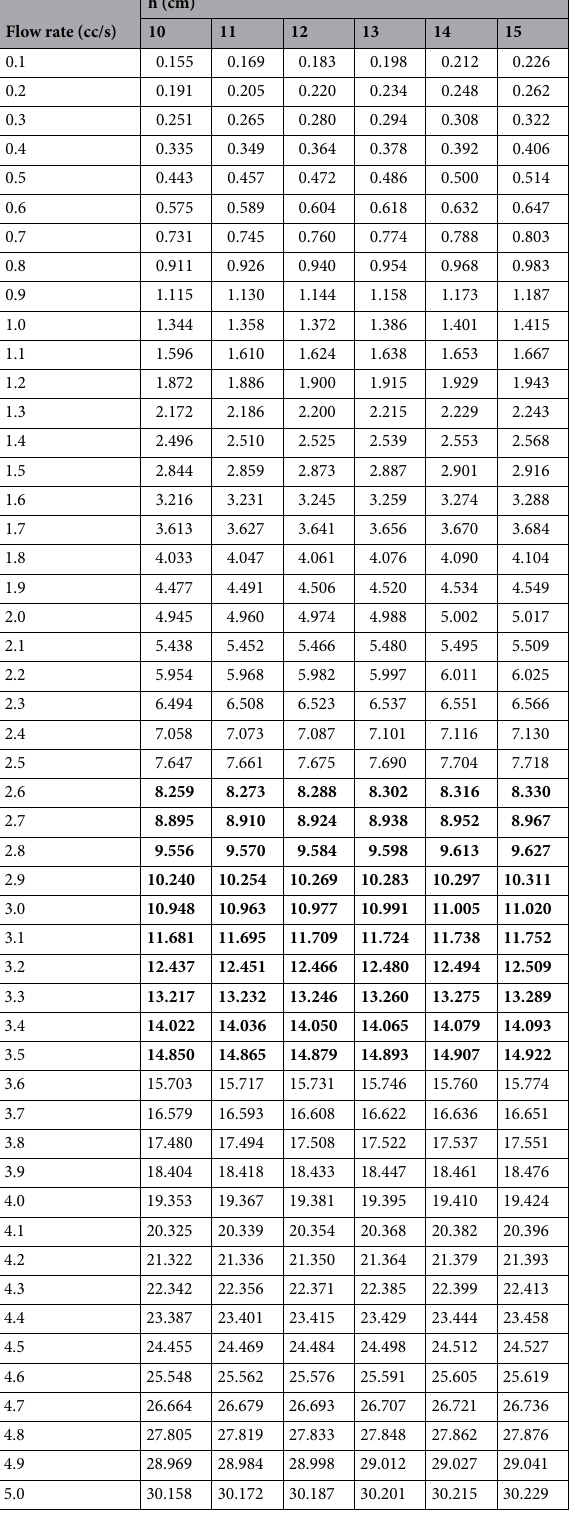
Table 2. Flow rate analysis according to the height from the wound of 20 gauge. Significant values are in